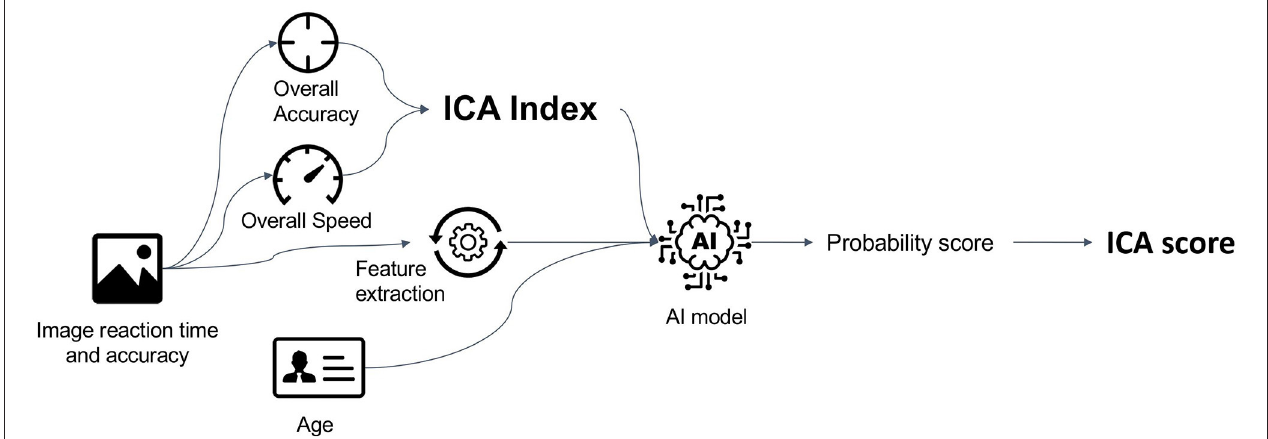
FIGURE 1 | Data features from the ICA test, as well as age are used as features to train the AI model. The trained model is able to give predictions on new unseen data. The AI model outputs a probability score between 0 and 1, which is converted to an ICA